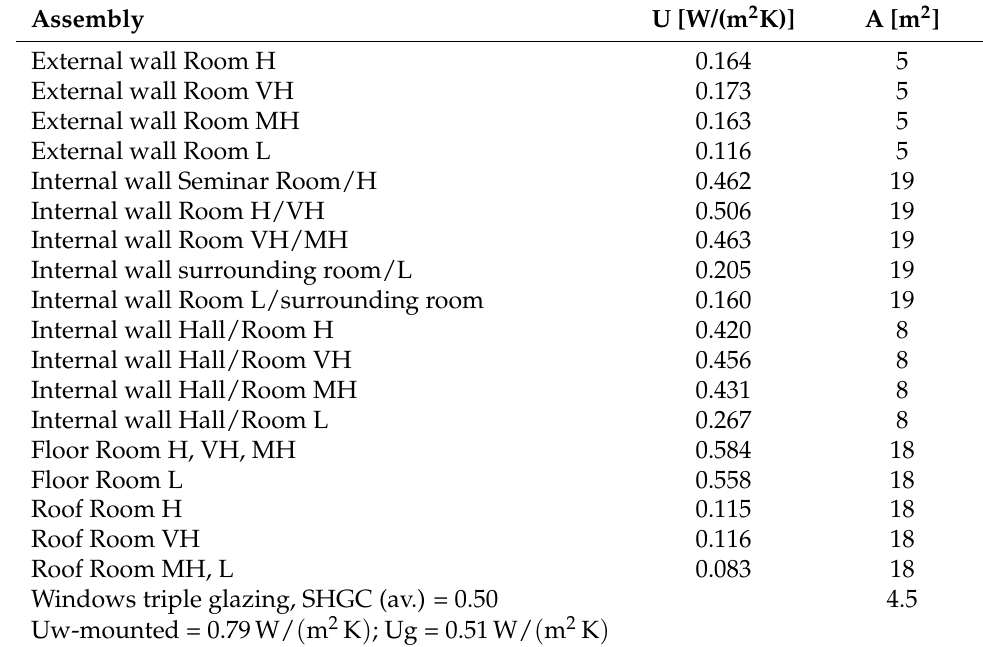
Table 1. Thermal transmittance coefficients and area of assemblies of experimental rooms.